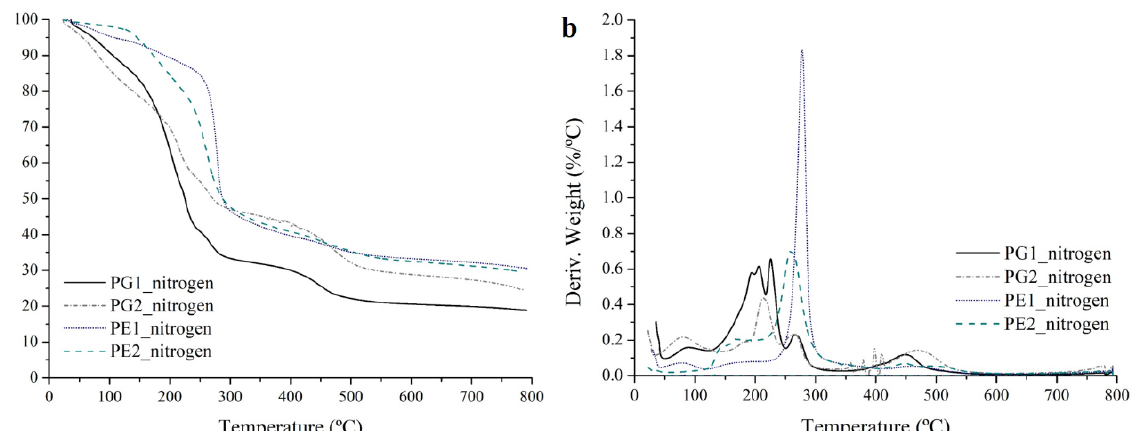
Figure 8. ( a ) SEM analysis and ( b ) EDX analysis of sample PE2.